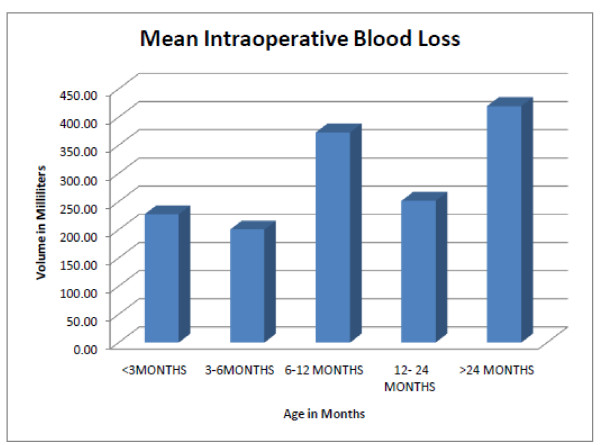
Blood loss during surgery was higher in older patients (P < 0.05) but a spike in blood loss occurred in the 6 mo-12 mo group because of presence of associated syndromes and a more complicated/protracted surgery in 2 pts in this group.